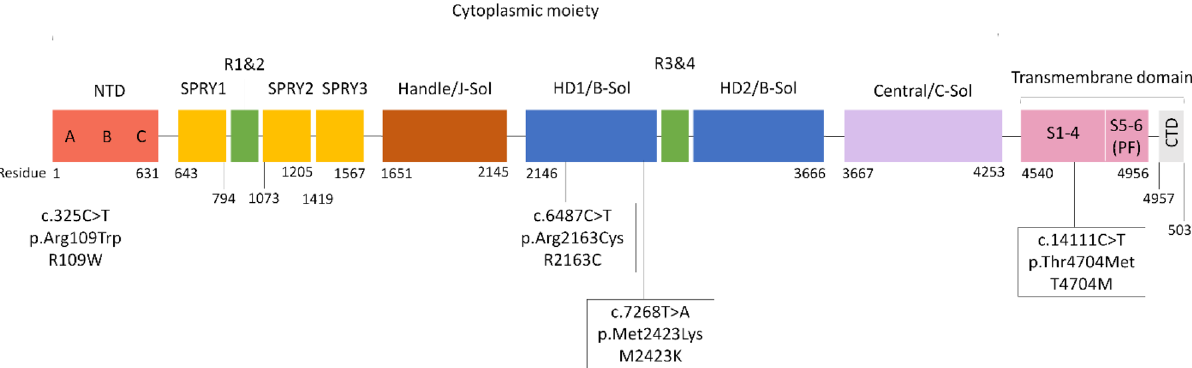
Figure 3. Schematic diagram of RYR1 protein subunit and pathogenic variants in this study. RYR1 is a homotetramer with each subunit consisting of a large cytoplasmic moiety and a transmembrane domain. This figure depicts one subunit of the RYR1 protein. The cytoplasmic moiety contains (1) the N-terminal domain (NTD) with 3 subdomains (A, B, C), (2) 3 SPRY domains (SPRY 1, 2, 3), of which SPRY 2 and 3 interact with the α1 subunit of DHPR at the II-III loop region, (3) a solenoid region comprising the handle/ junctional solenoid (J-sol) domain, and the helical (HD1, HD2)/ bridging solenoid (B-Sol) domains, (4) 2 tandem repeat domains (R1&2, R3&4), and (5) a Central domain or core solenoid (C-Sol). The transmembrane domain consists of 6 transmembrane helices (S1–6), and a C-terminal domain (CTD). S5 and 6, together with a